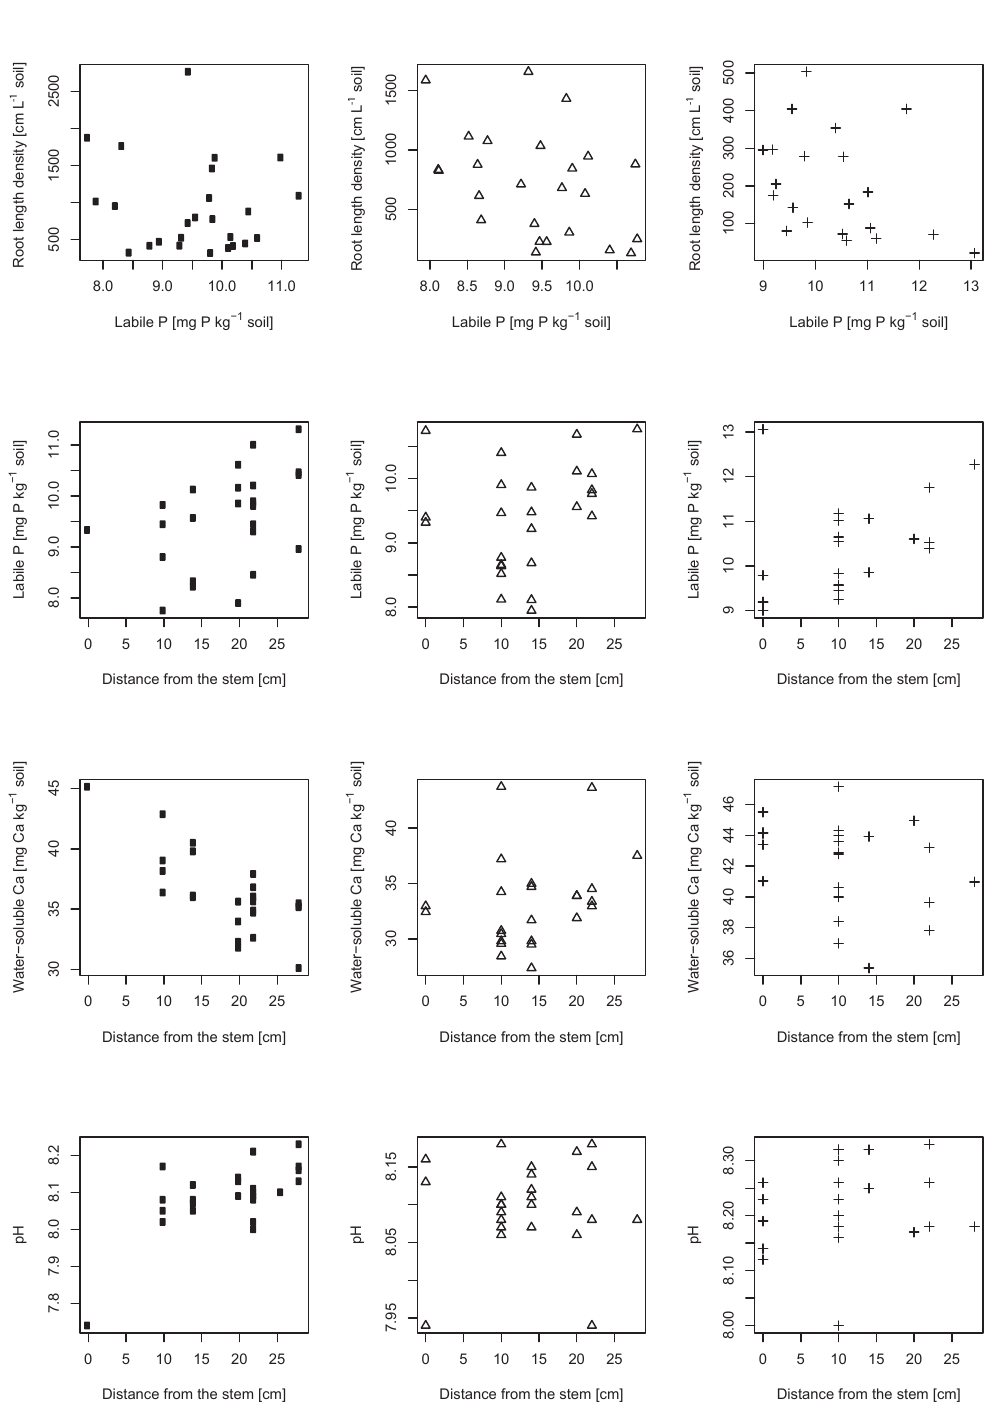
Fig. 5. The relationship between root length density and labile P (first row) as well as the the relationship between the distance from the stem and labile P (second row), water-soluble Ca (third row) or pH (fourth row) investigated in the high-density sampling on the Chicken Creek Catchment (CCC) in the topsoil (0–10cm) of the plots with low (plot 1), intermediate (plot 2) and high vegetation density (plot